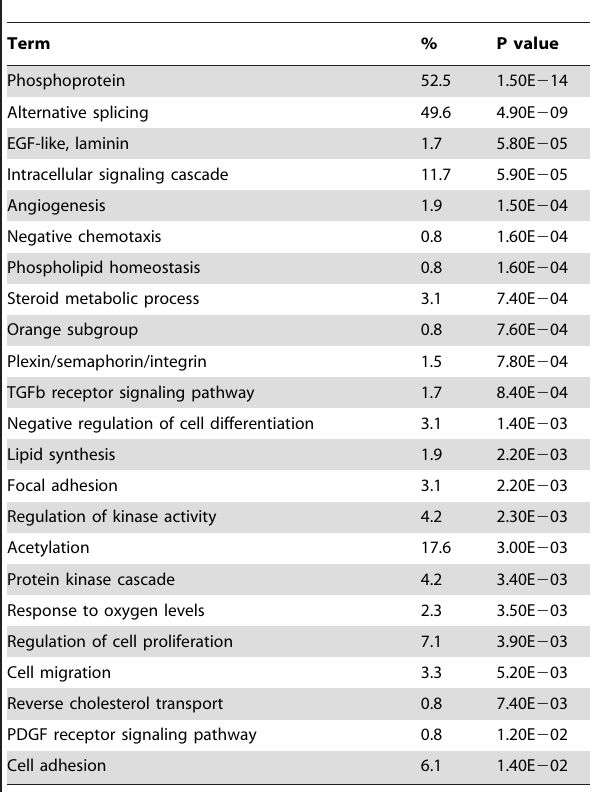
Table 1. EASE pathway analysis of differentially expressed